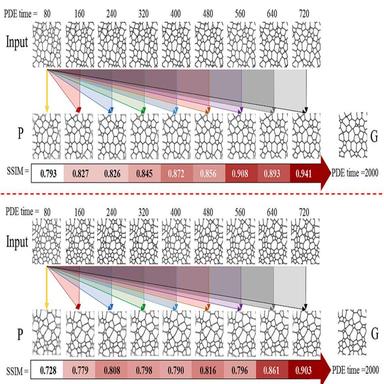
Examples of the 25th frame predicted by the model trained on different lengths of input sequence. G and P indicate ground truth and prediction. SSIM: structural similarity index measure.